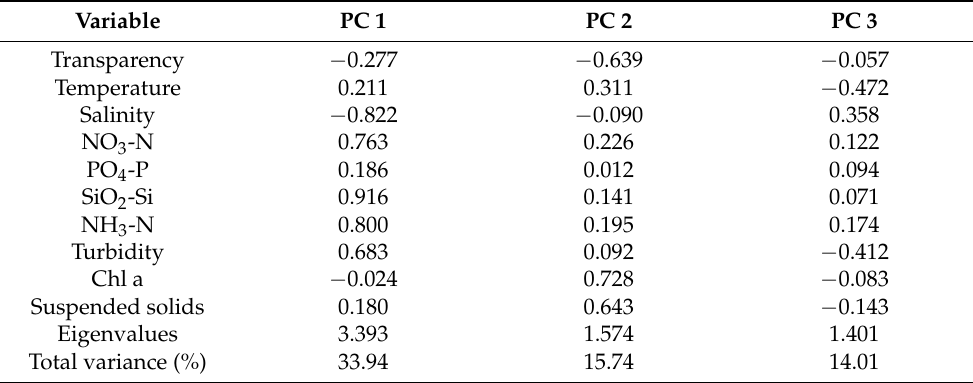
Table 2. Loadings of principal components 1–3 (after varimax rotation) for abiotic variables measured in the study area (N =